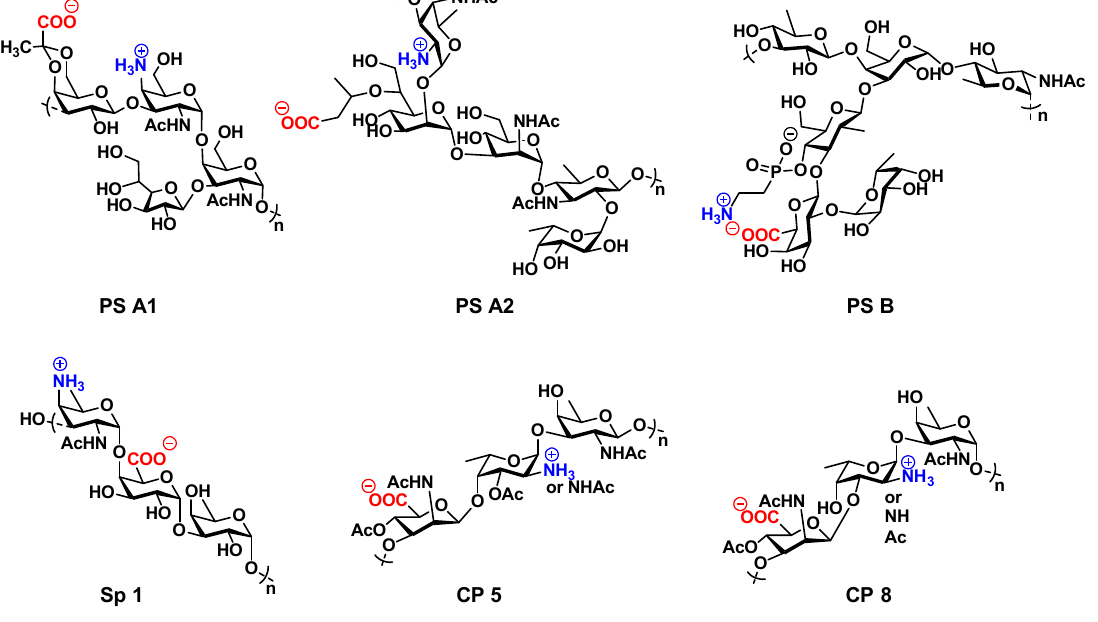
Figure 2. Structures of zwitterionic polysaccharides (ZPSs).